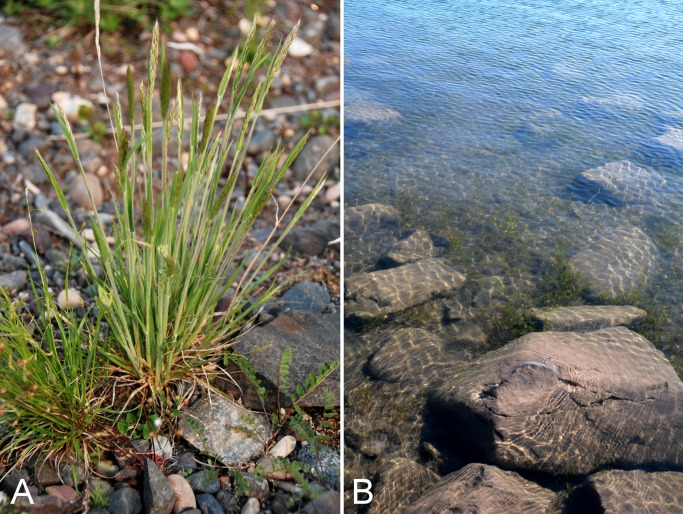
Trisetum spicatum and Stuckenia pectinata.Trisetum spicatum: (A) habit, Saarela et al. 3376. Stuckenia pectinata: (B) habitat, Saarela et al. 4277. Photographs by J. M. Saarela (A) and P. C. Sokoloff (B).